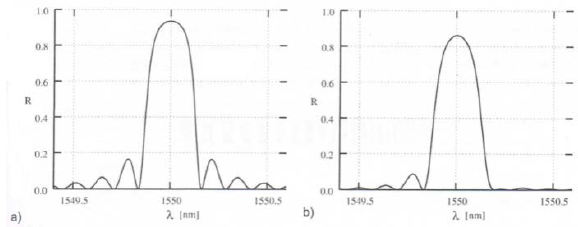
Fig. 5. Reflection spectrum of Bragg fiber grating а) without apodization, b) apodized